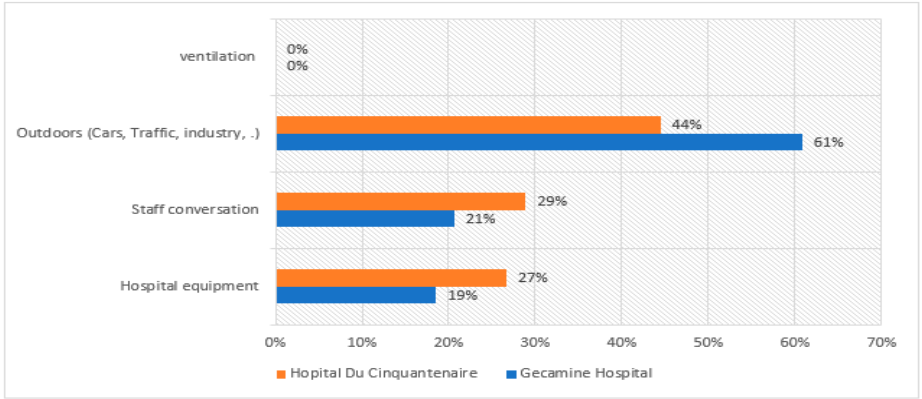
Figure 4. Subjective rating for the different noise sources generated in both intensive care units.